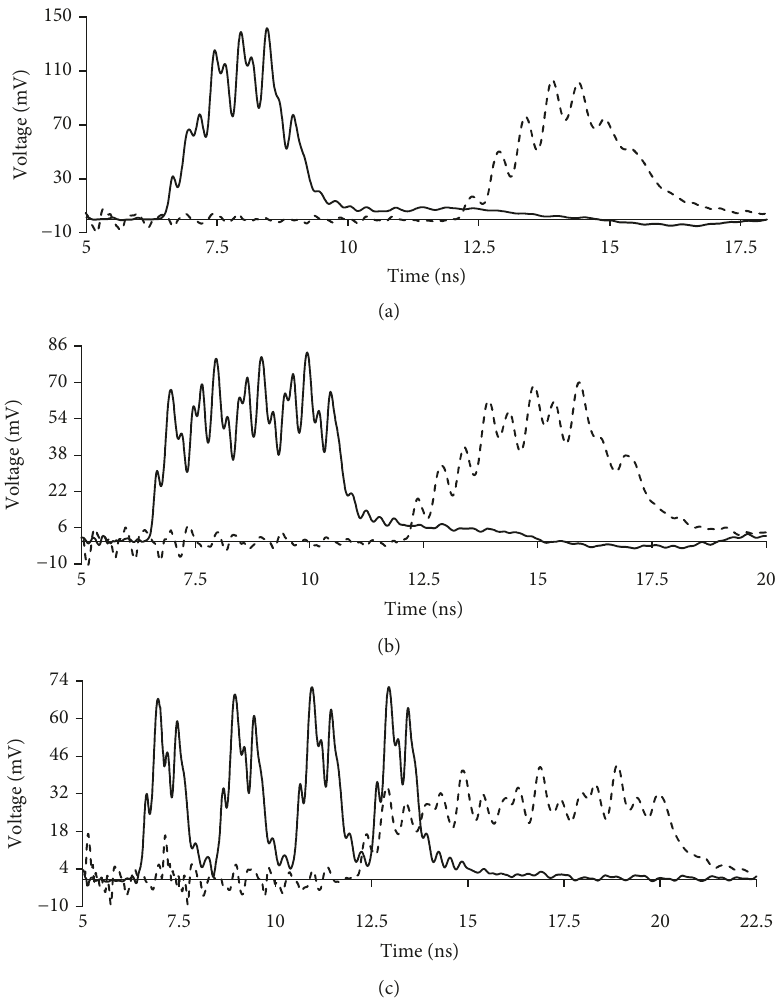
Figure 10: Voltage waveforms at the output of the reflection symmetric ( – ) MF and (- -) ML when excited by a USP train with repetition periods of (a) 0.5, (b) 1, and (c) 2ns. Table 5: Amplitudes at the output of the structures. Repetition period of pulses in the USP